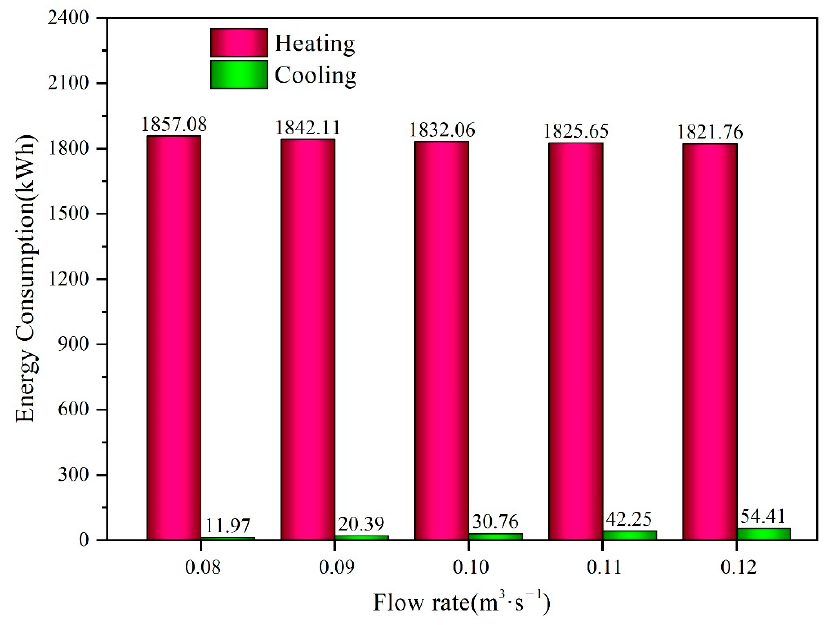
Figure 7. During the ventilated month of the south wall, the energy consumption of the room when the flow rate among air layer 2, air layer 3, and room is at different